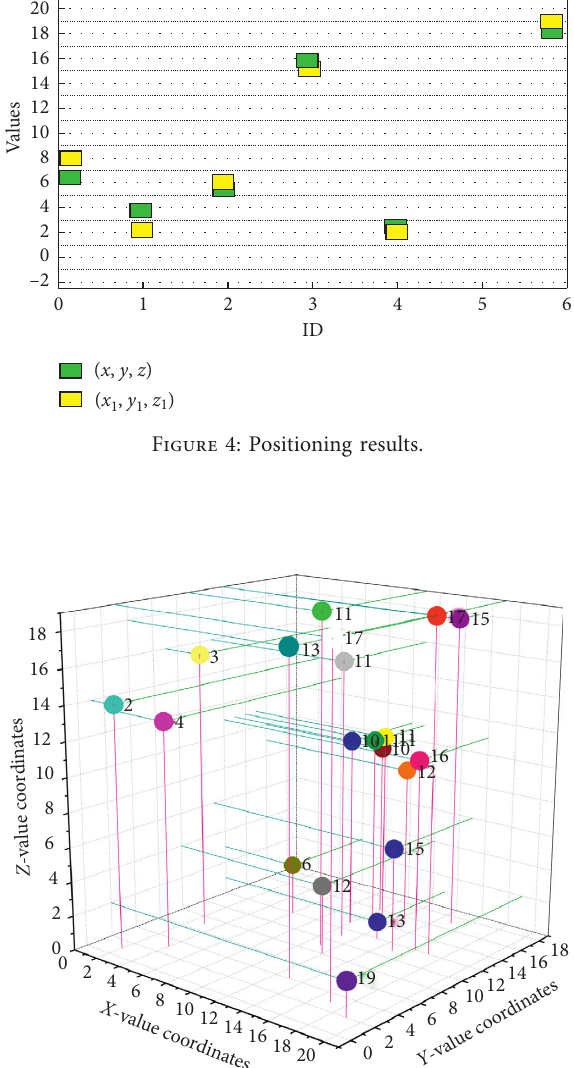
Figure 5: Point (12, 3, 0) measurement